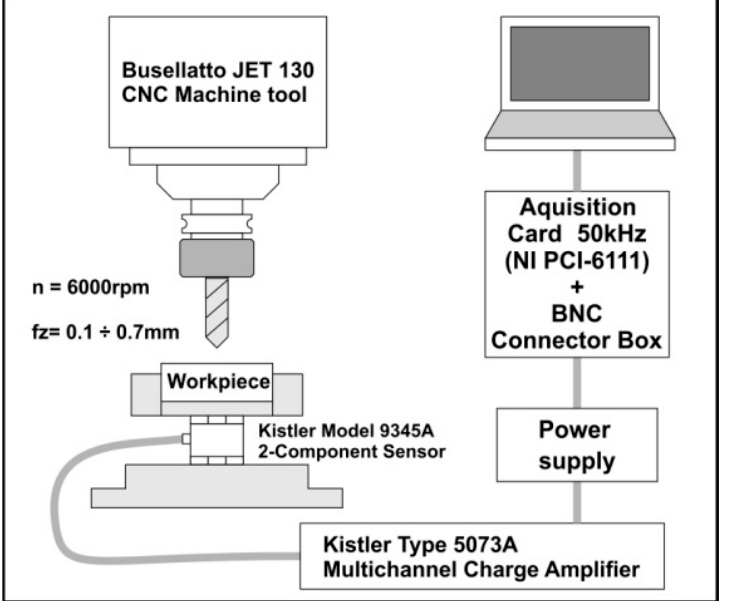
Figure 1. The scheme of the test stand used during the earlier, significantly reliable machinability testing [12].